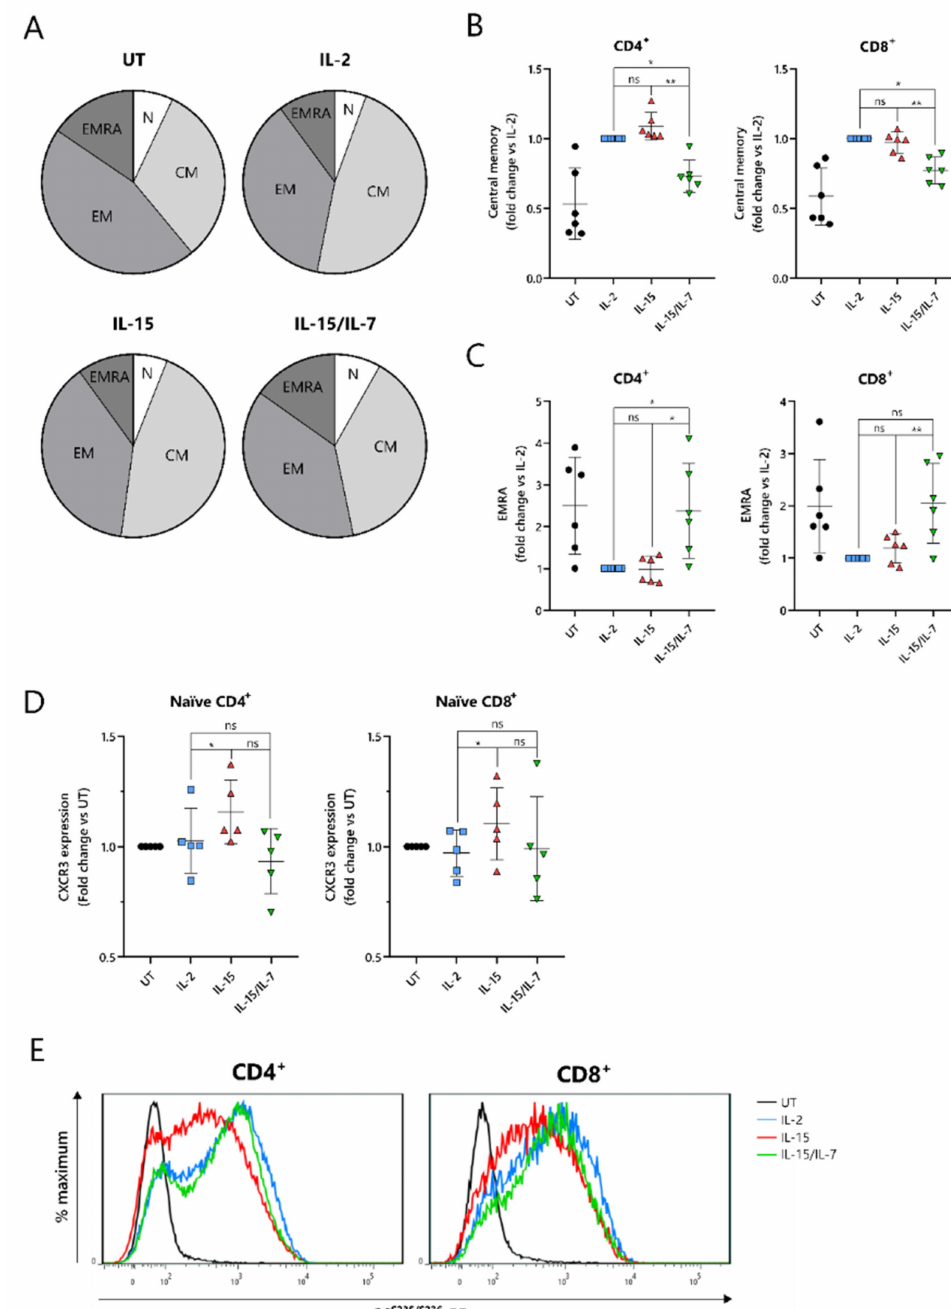
Figure 4. IL-7 drives a more differentiated memory phenotype in ARI2h BCMA-CARs cultured with IL-15. ( A ) Pie charts showing a summary of phenotypes of in vitro-expanded CD8 + (UT) and CD8 + CAR + (ARI2h IL-2 , ARI2h IL-15 , ARI2h IL-15/IL7 ) T cells. N—naïve (CCR7 + CD45RA + ), CM—central memory (CCR7 + CD45RA − ), EM—effector memory (CCR7 - CD45RA −